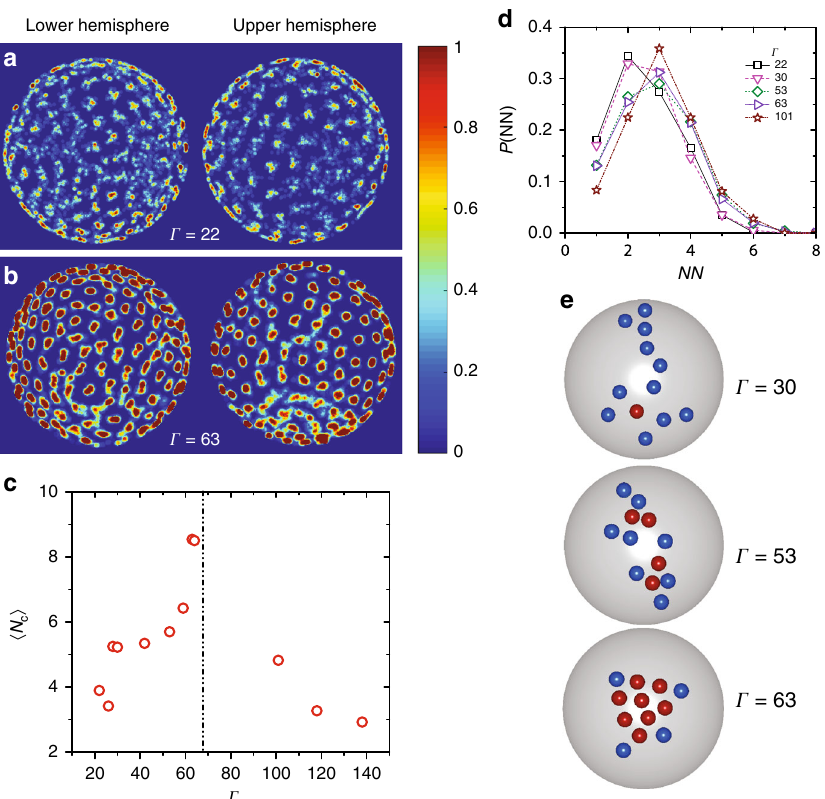
Fig. 3 Change in shape of CRRs on approaching the MCT crossover. a , b Particle displacement map over the cage-breaking time t * for Γ = 22 and Γ = 63, respectively. Here colors represent overlap values with red representing high particle overlap over t * and blue representing poor overlaps indicating particles having made hop. c Average cluster size 〈 N c 〉 verses Γ (red open circles), 〈 N c 〉 shows a maximum at mode-coupling crossover Γ MCT (vertical black dash-dot line). d Distribution of the number of fast nearest-neighbors for a mobile particle, P (NN), for Γ = 22 (black squares), Γ = 30 (magenta triangles), Γ = 53 (olive green squares), Γ = 63 (violet triangles), and Γ = 101 (wine stars). The peak of P (NN) shifts from NN = 2 to NN = 3 indicating that dynamical heterogeneities becoming more compact with increasing Γ . e Representative dynamical heterogeneities of 12-particle clusters for Γ = 30, 53, and 63. Particles that comprise the core of dynamical heterogeneities are shown in red while the stringy particles are shown in